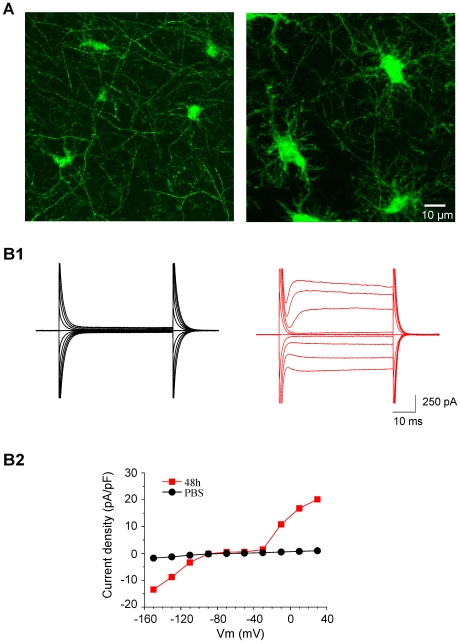
Activation of microglial cells 48 h after status epilepticus (SE) induced by intra-peritoneal injection of kainate.A Confocal images of fluorescent microglial cells in the stratum radiatum of the CA1 region of the hippocampus of CX3CR1egfp/+ mice in control conditions (left) or 48 h after SE (right). Each image is a maximum intensity z-projection of 31 confocal slices for a total thickness of 12 µm. B1 Examples of current responses induced by voltage steps of 20 mV increment from −150 to +30 mV (holding potential −70 mV) in microglial cells in control (left, black traces) and 48 hours after the induction of status epilepticus (right, red traces). B2 I/V curves of the cells showed in B1 normalized to their capacitance. The activated microglial cell expressed both inward and outward rectifying currents (red plot).